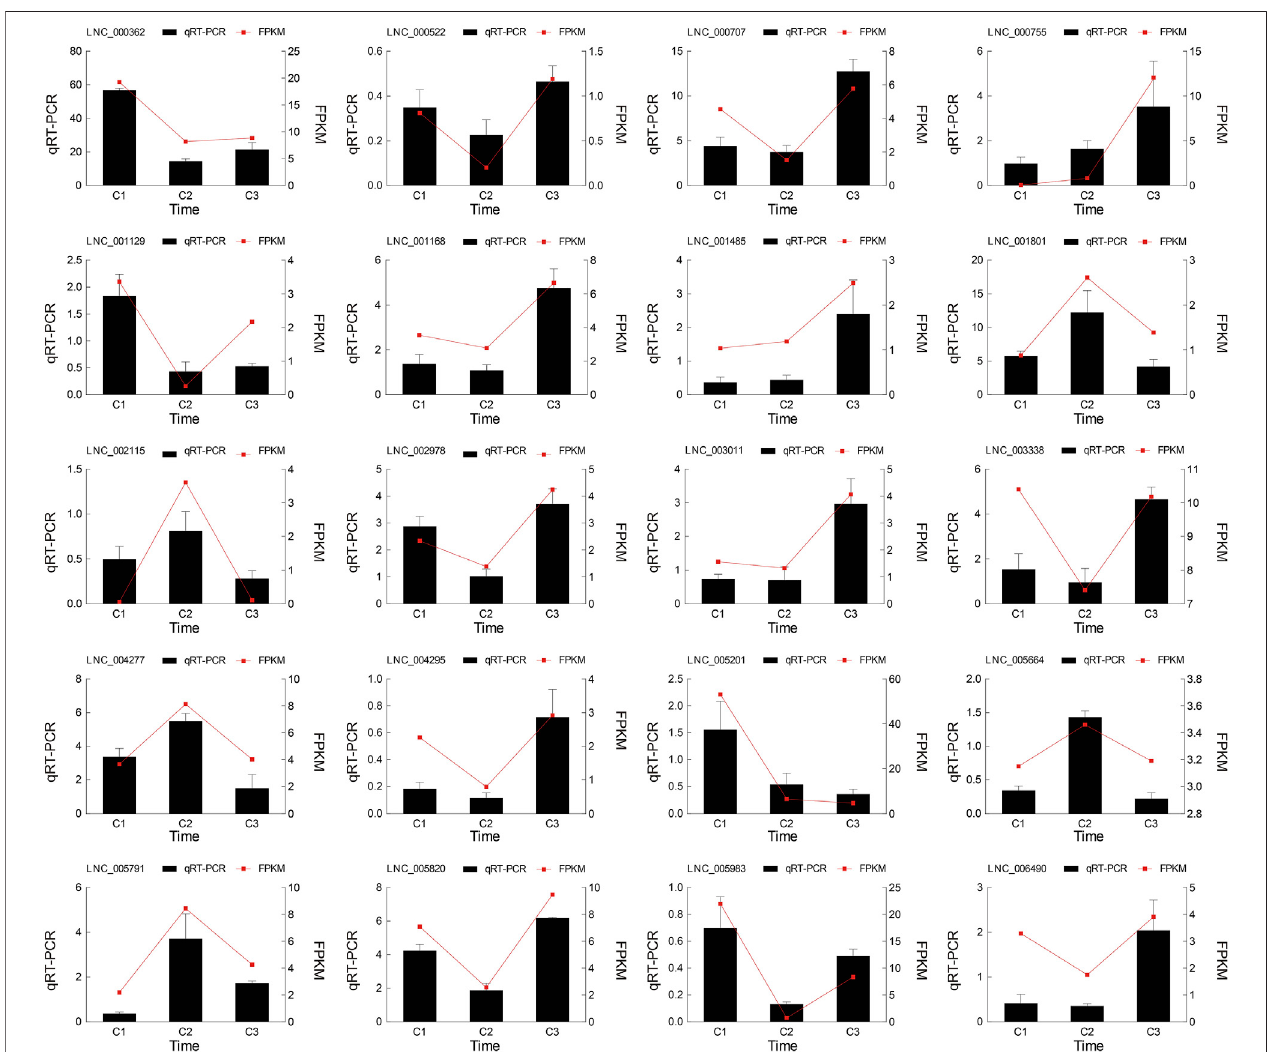
FIGURE 4 | The comparison of the 20 lncRNAs ’ real-time quantitative RT-PCR (qRT-PCR) and RNA sequencing (RNA-seq). Both datasets of hickory female fl oral development periods were in good agreement. The columns represented the results of the qRT-PCR, and the red lines represented the results of the